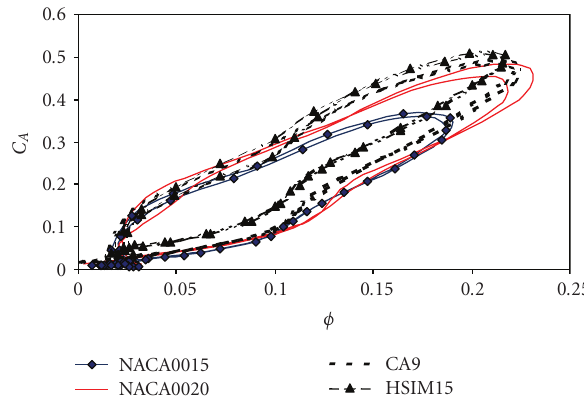
Figure 14: E ff ect of blade profile on the hysteretic characteristics of Wells turbine under real sea conditions (site2) at 1 κω ∗ = 0 . 18, σ =